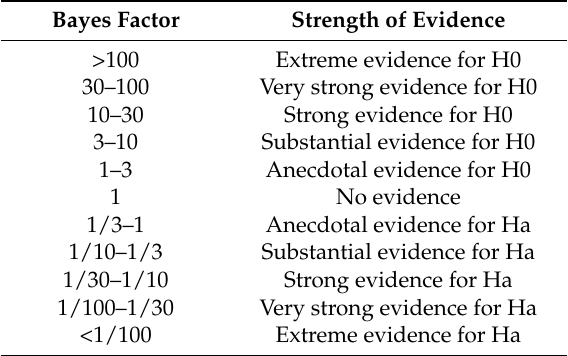
Table 1. Classification scheme for the Bayes Factor, proposed by Jeffreys